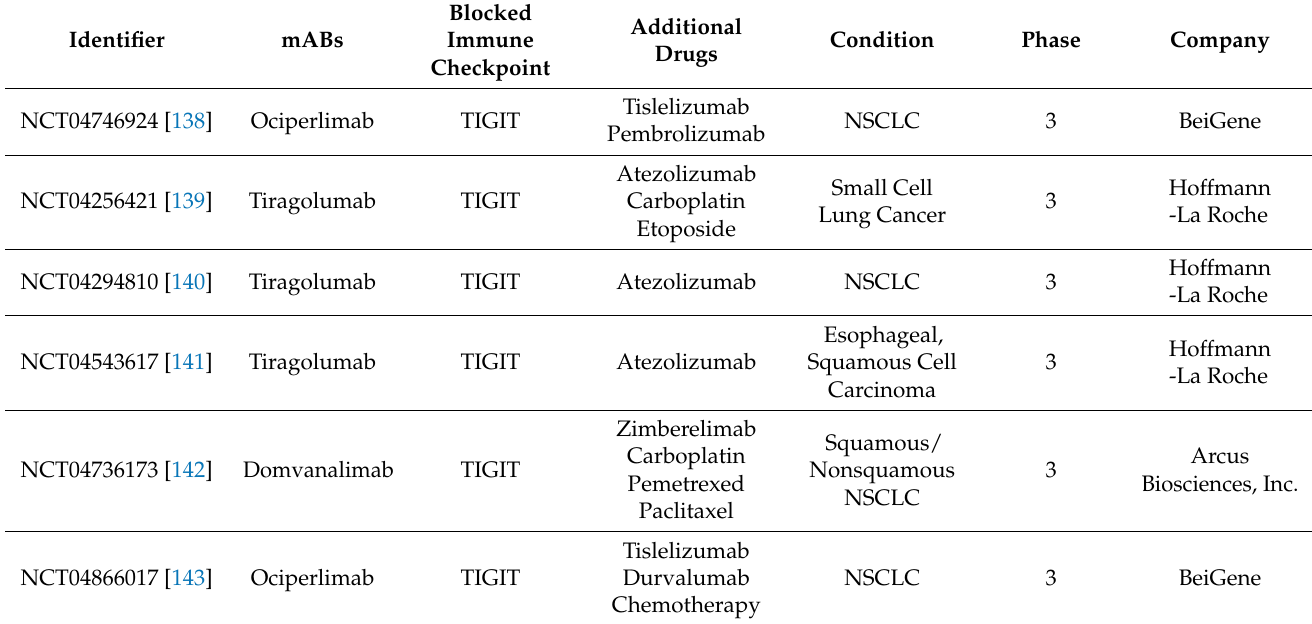
Table 1. The ongoing clinical trials using anti-TIGIT mAbs at advanced stages in cancer